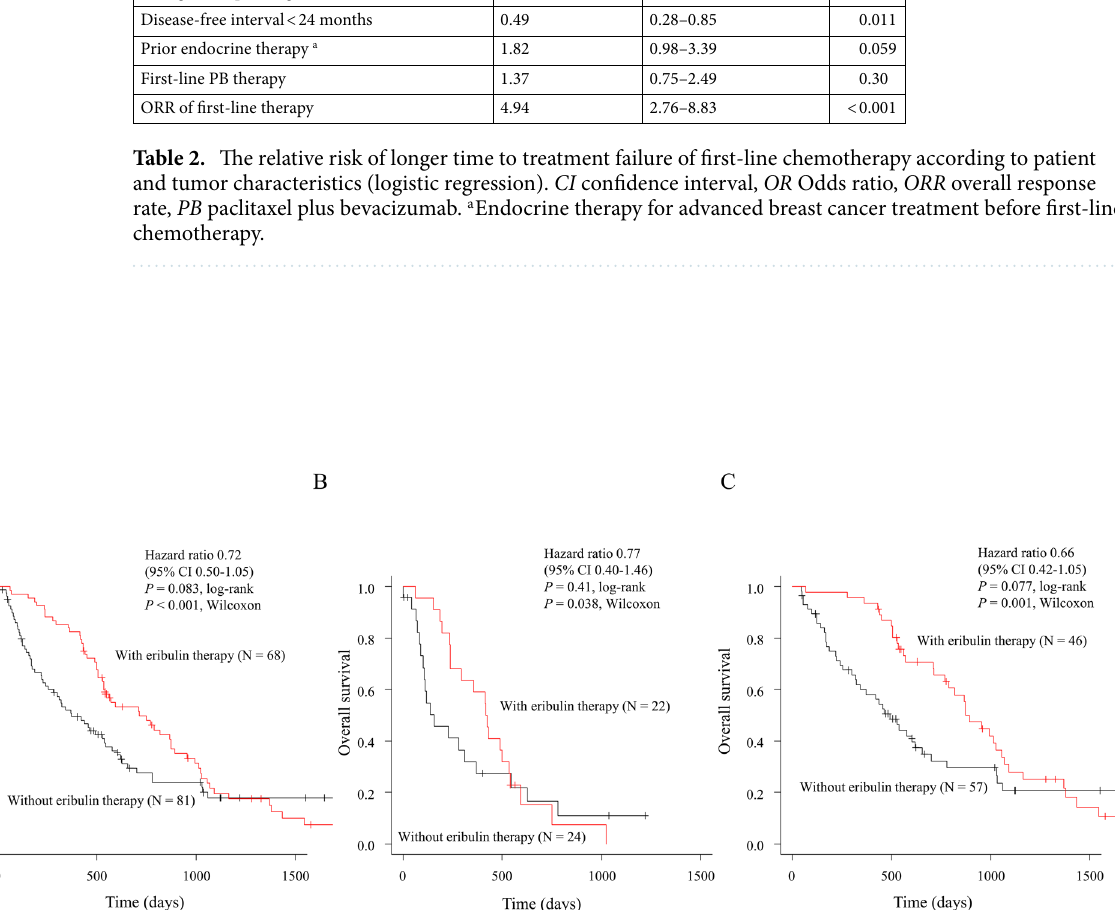
Figure 2. Overall survival with and without eribulin therapy in the shorter time to treatment failure group ( A ), in the PB group ( B ), and in the non-PB group ( C ). CI confidence interval, HR hazard ratio, PB paclitaxel plus